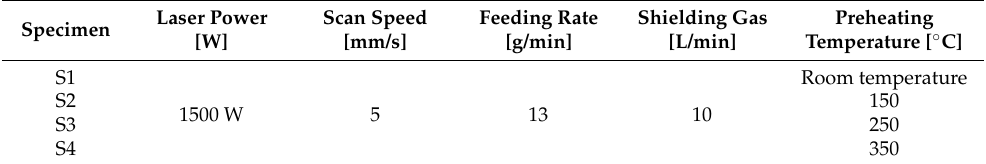
Figure 3. Temperature contour diagrams when the substrate was preheated to a predetermined temperature: ( a ) 150 °C; ( b ) 250 °C; ( c ) 350 °C; ( d ) temperature monitoring points. Table 3. Parameters of LC